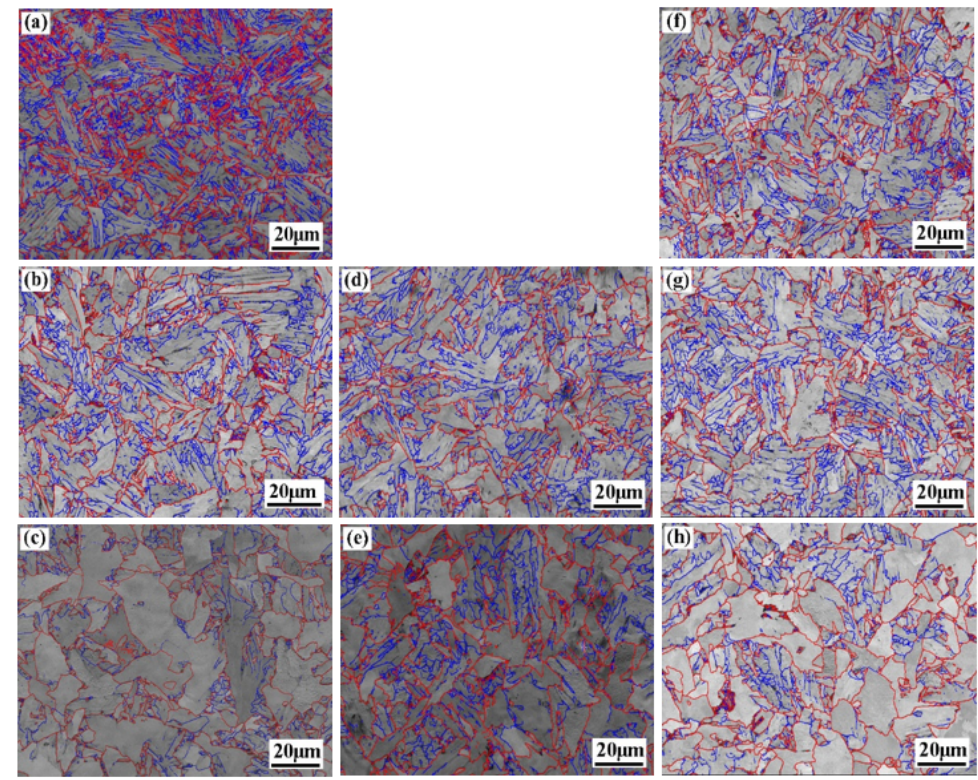
Figure 6. EBSD image quality maps with grain boundary misorientation distribution at the different temperature measurement points. Images ( a – h ) show the results for points P1–P8, respectively.